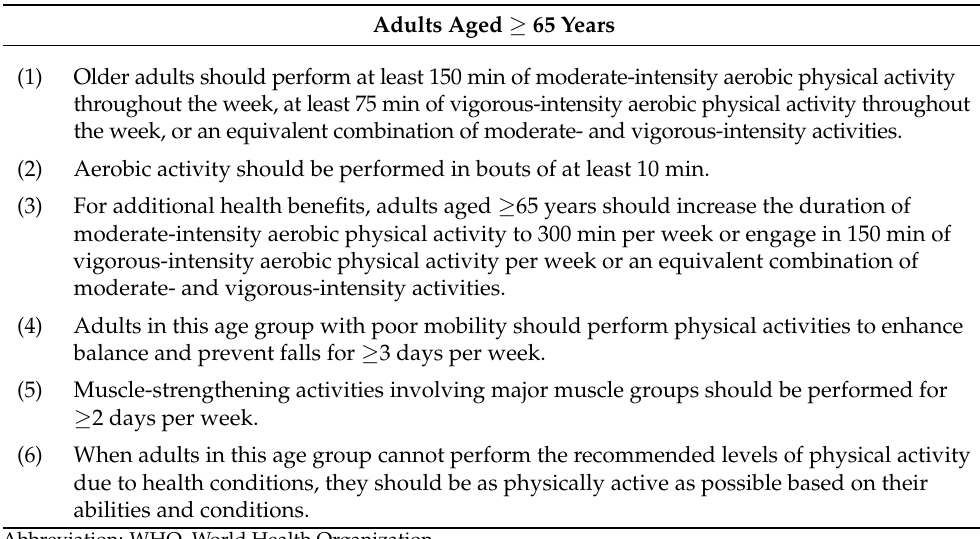
Table 1. WHO global recommendations on physical activity for